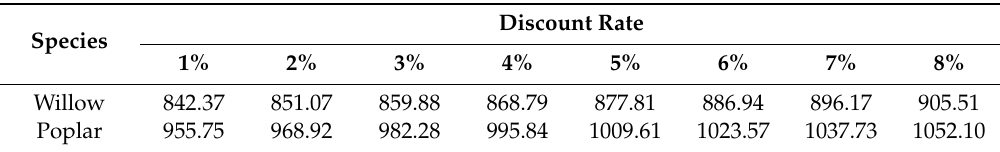
Table 5. Sensitivity analysis of carbon dioxide sequestration value CS (EUR ha − 1 ) of poplar and willow. The values of each species are summarized during